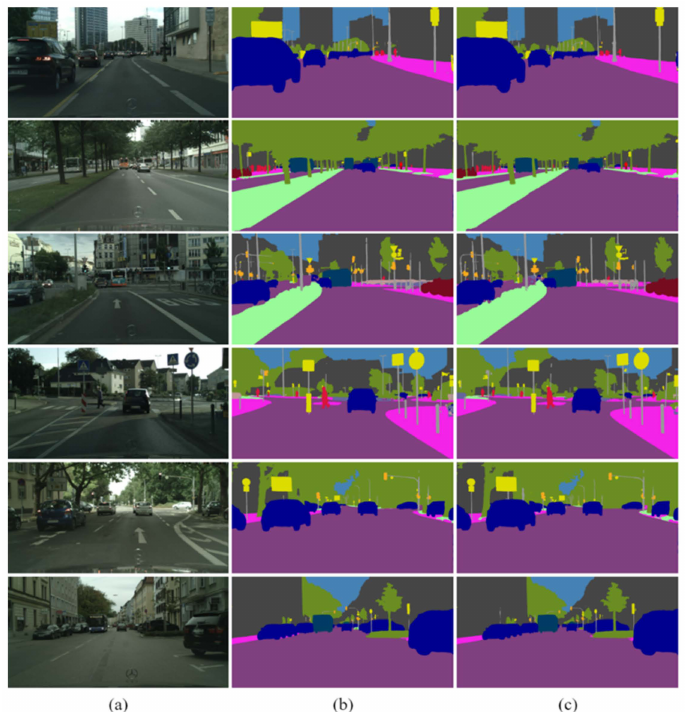
Figure 5. ( a ) Input image and the results of the ( b ) ResNet-18 backbone [28] and the ( c ) HarDNet- 68ds [37] backbone.